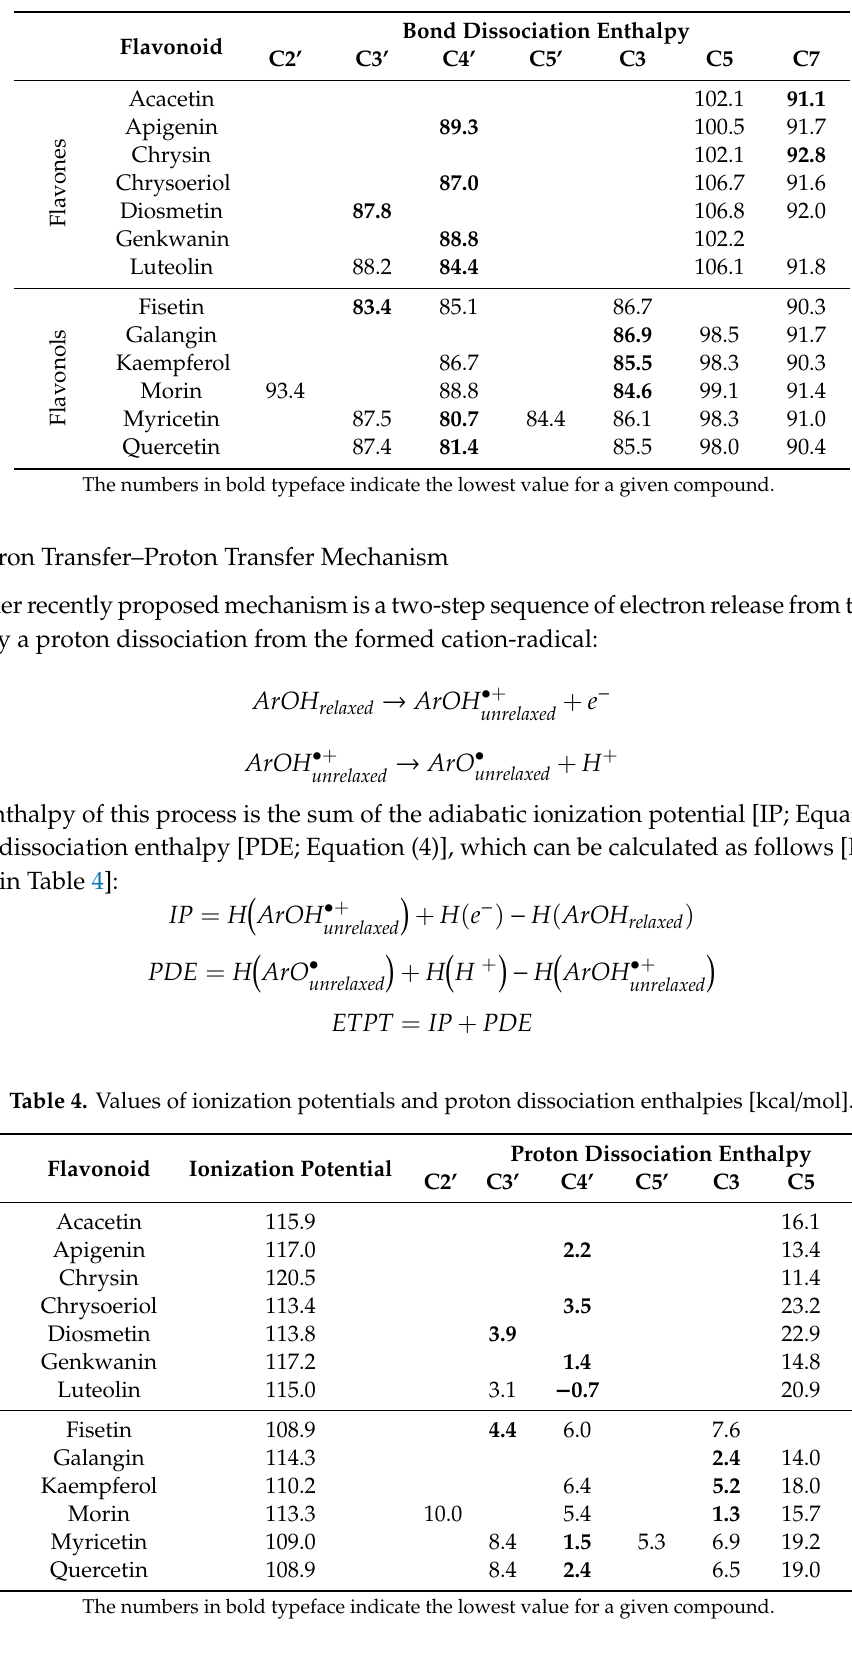
Table 3. Values of bond dissociation enthalpies [kcal / mol].